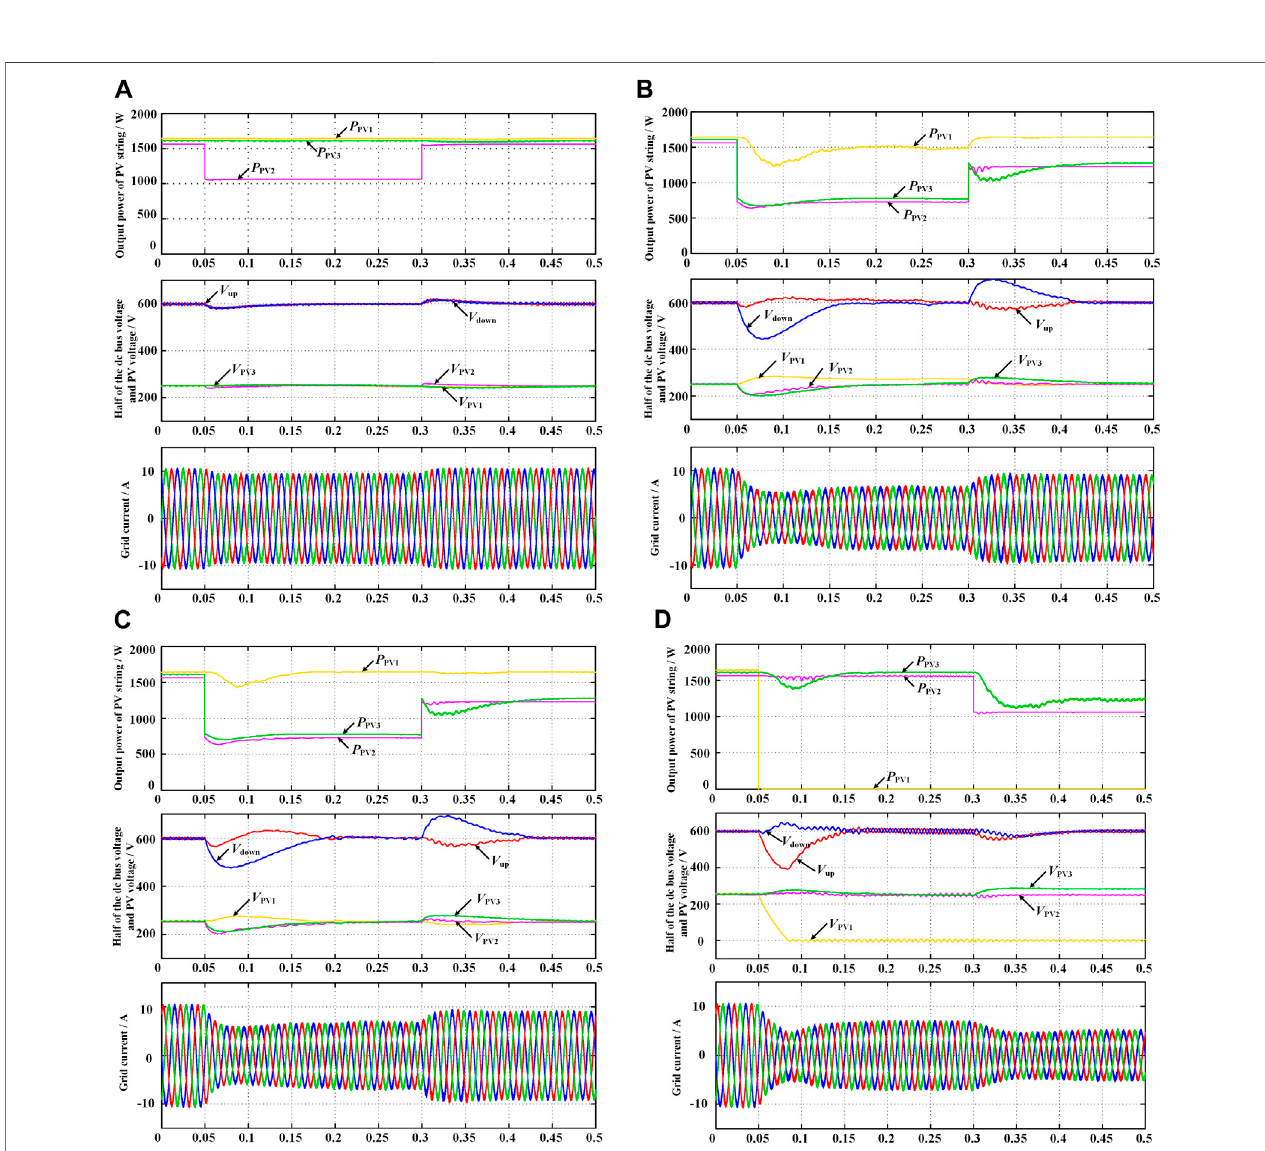
FIGURE17|(A) Simulated waveforms when thePV2 irradiance declines from 950 W/m 2 to650 W/m 2 at0.05 sand recovers to950 W/m 2 at 0.3 s, (B) simulated waveforms when the irradiation levels of PV2 and PV3 reduce from 950 W/m 2 to 450 W/m 2 and from 980 W/m 2 to 480 W/m 2 , respectively, at 0.05 s and recover to 750 W/m 2 and 780 W/m 2 , respectively, at 0.3 s, (C) simulated waveforms when the variation of the irradiation level of PV2 and PV3 is the same as that in the previous case, butthe inverter isinvolved tobalance thedc-link voltage, and (D) simulatedwaveformswhenthe irradiation level ofPV1reducesto0 W/m 2 at 0.05 sand the irradiation level of PV2 reduces by 300 W/m 2 at 0.3